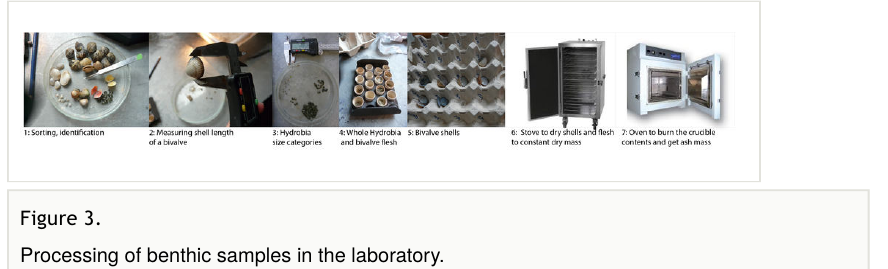
Figure 3. Processing of benthic samples in the